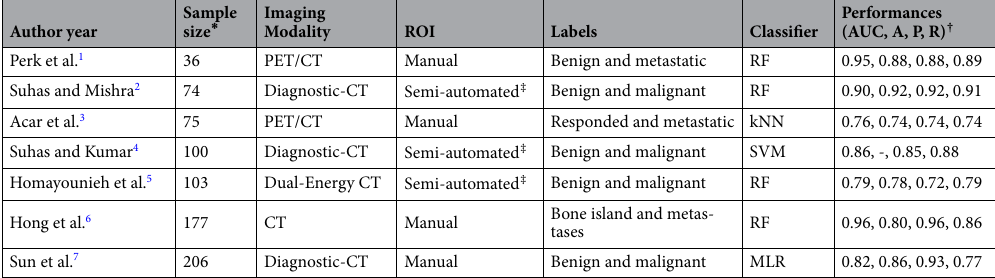
Table 1. Radiomics-based ML models reported in the literature for distinguishing bone lesions. size is the total number of samples. † A accuracy, P precision (Specificity), R recall (sensitivity). ‡ In the semi- automated segmentation methods an expert was required to check and modify the computer-segmented ROIs